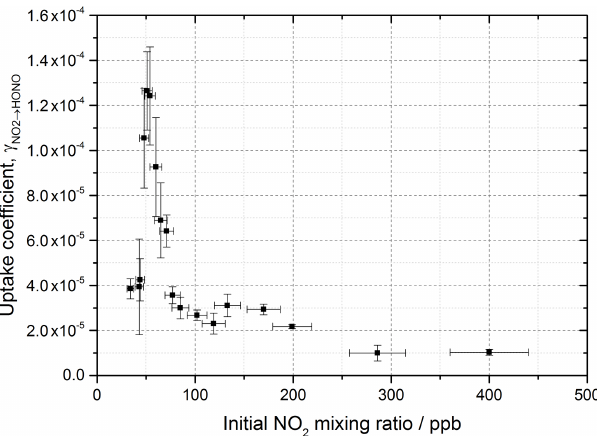
Figure 8. Experimental results showing the reactive uptake coef- ficients of NO 2 to form HONO, γ NO , onto TiO 2 aerosol 2 → HONO surfaces as a function of the initial NO 2 mixing ratio. All exper- iments were conducted in N 2 at 295K at 15 ± 1% RH, a photon flux of (1.63 ± 0.09) × 10 16 photonscm − 2 s − 1 and an illumination time of 52 ± 2s. γ NO was determined for each NO 2 mix- 2 → HONO ing ratio from the gradient of the pseudo-first-order rate coefficient for HONO production, k , versus aerosol surface area density varied from 0–0.04m 2 m − 3 (e.g. as shown in Fig. 4) and Eq. (8).